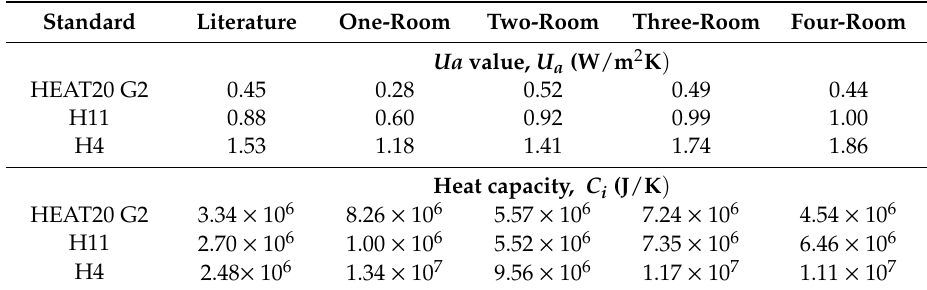
Table 3. Summary of identified thermal performance parameters. The median of estimation results for Ua values ( U a ) and heat capacity ( C i ) for each standard (HEAT G2, H11, and H4) and models (one-, two-, three-, and four-room) are represented.